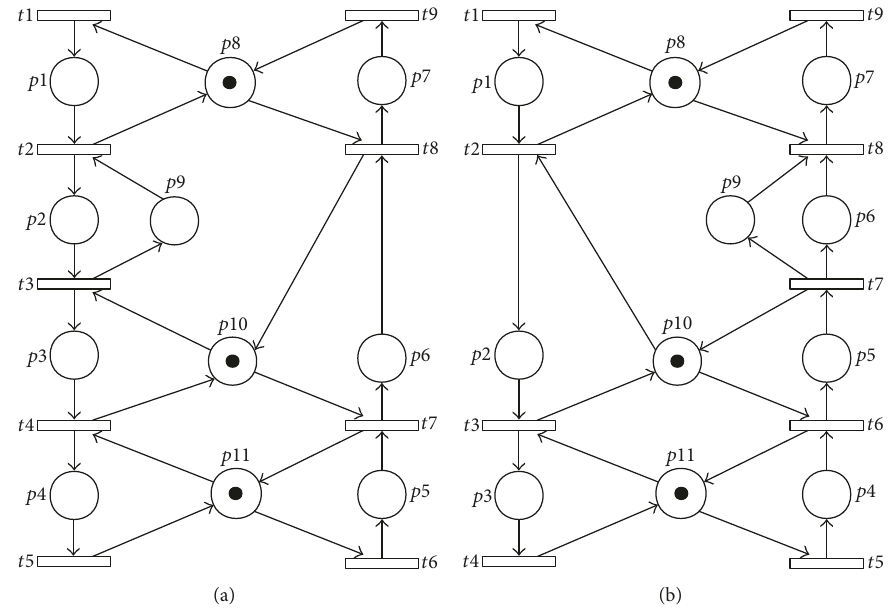
Figure 9: Two reduced S 3 PR models derived from Figure 3.